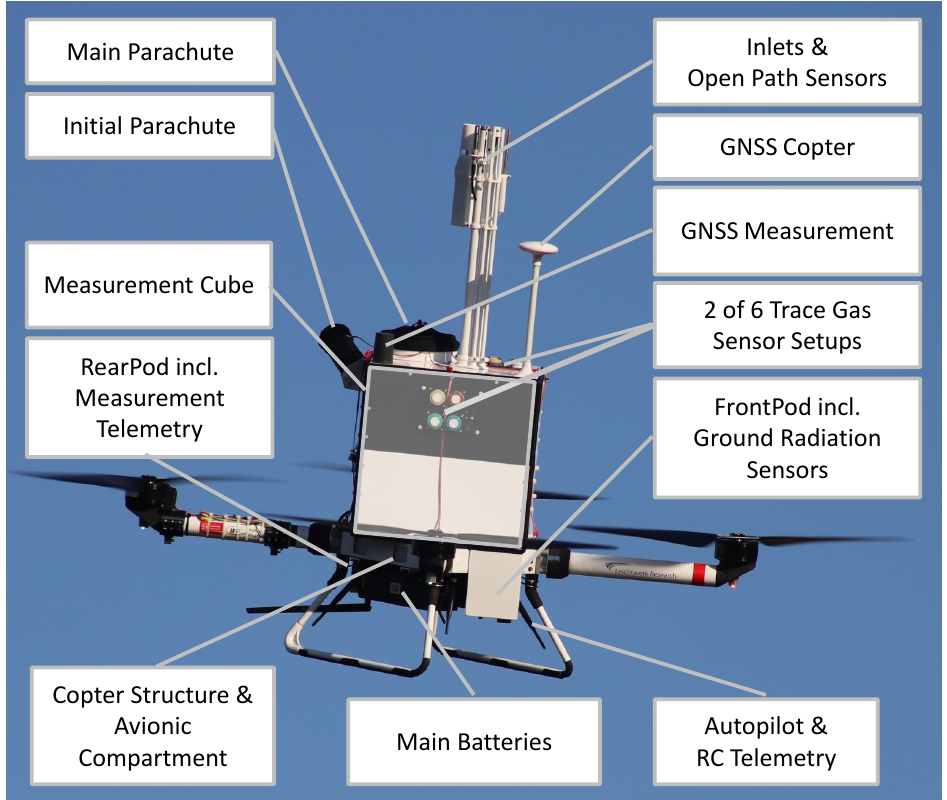
Figure 2. Overview of the MesSBAR quadrocopter with main components. GNSS refers to the Global Navigation Satellite System, RC to remote